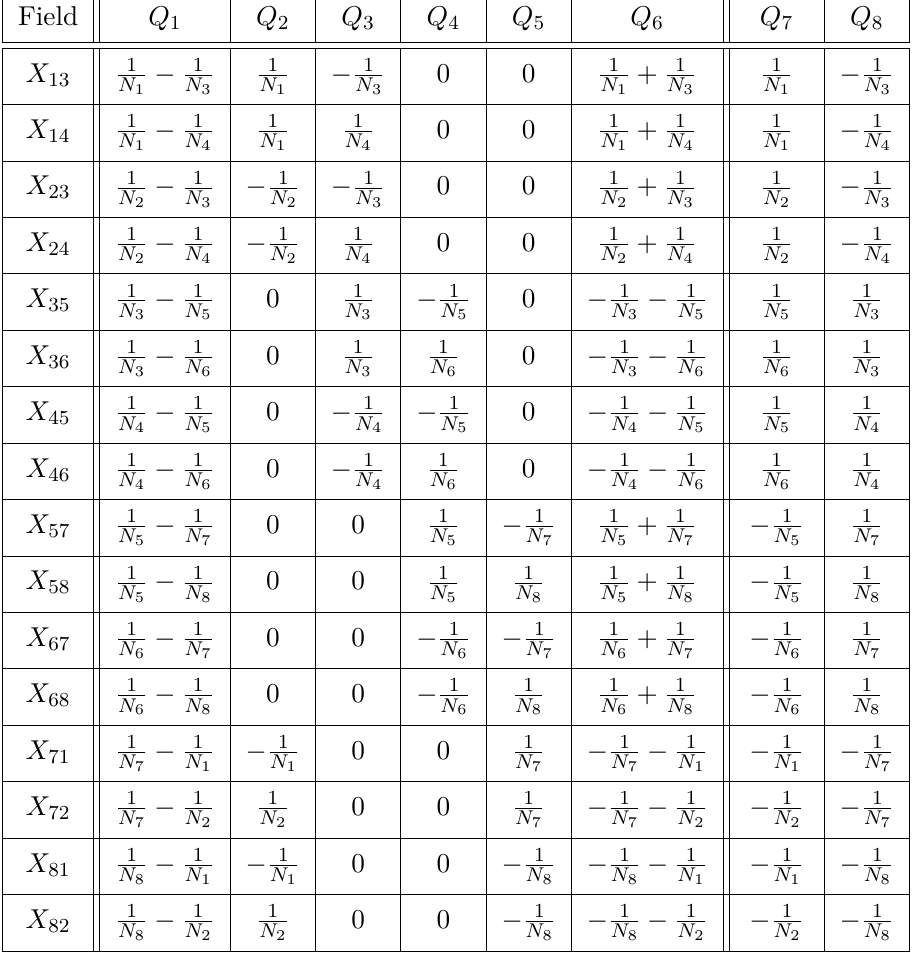
Table 1 . List of U(1) charges for the bi-fundamentals appearing in the quiver diagram 3.